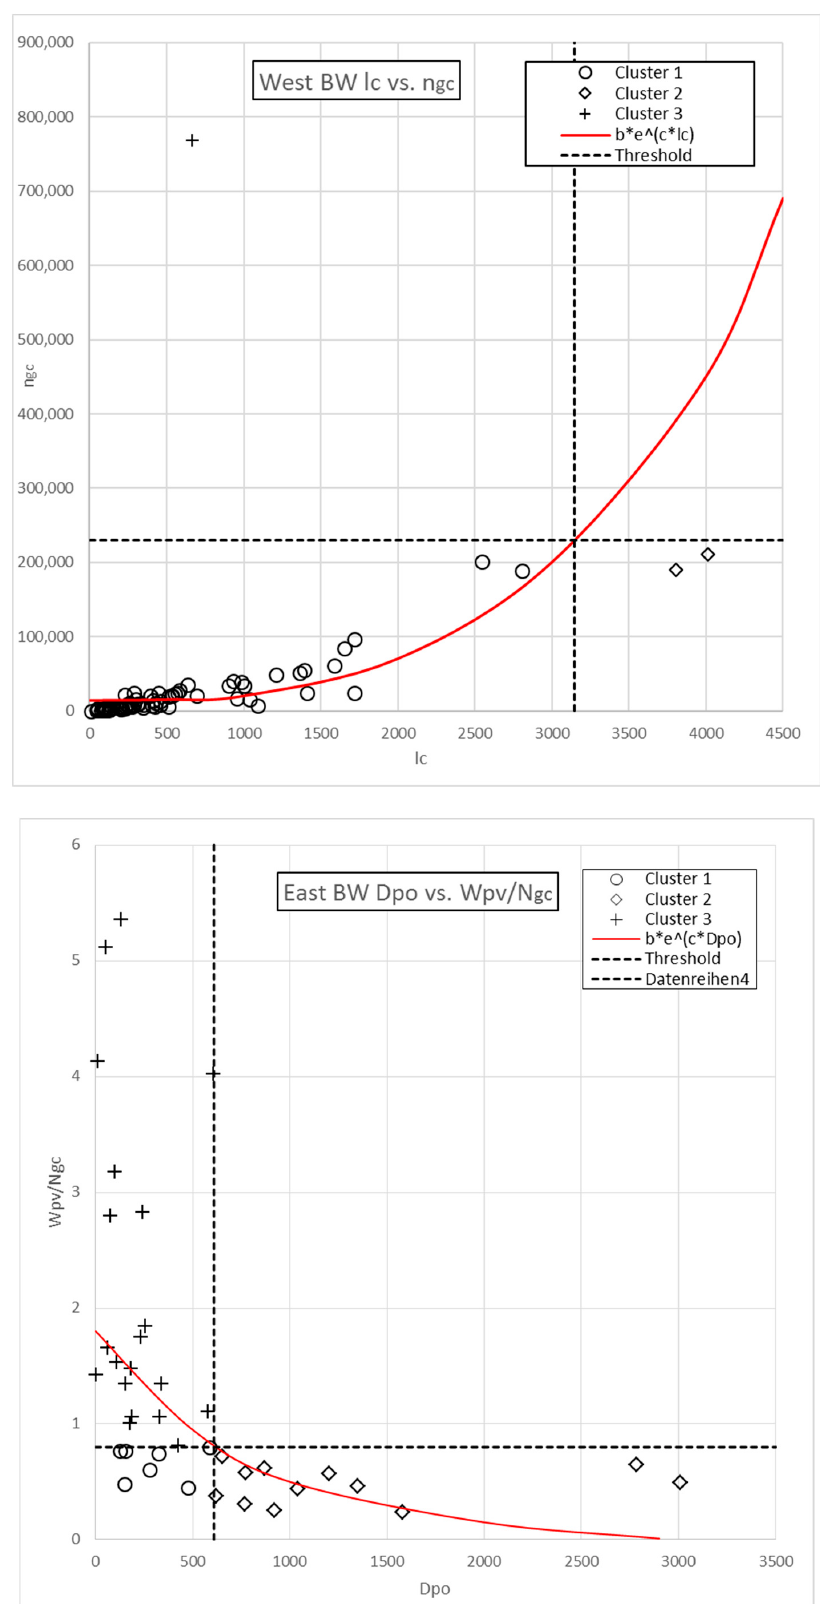
Figure 12. Cont Figure 12. Cont.